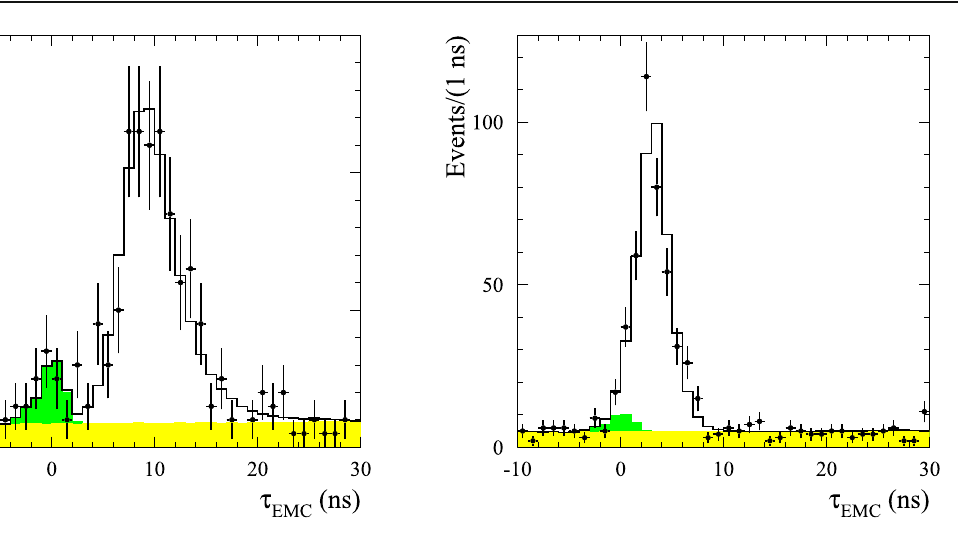
Table 1 The beam energy ( E b ), integrated luminosity ( L ), number of selected n ¯ n events ( N n ¯ n ), the factor taking into account radiative cor- rections and energy spread (1 + δ ), detection efficiency ( ε ), measured e + e − → n ¯ n crosssection σ ,andneutroneffectiveformfactor( F n ).The